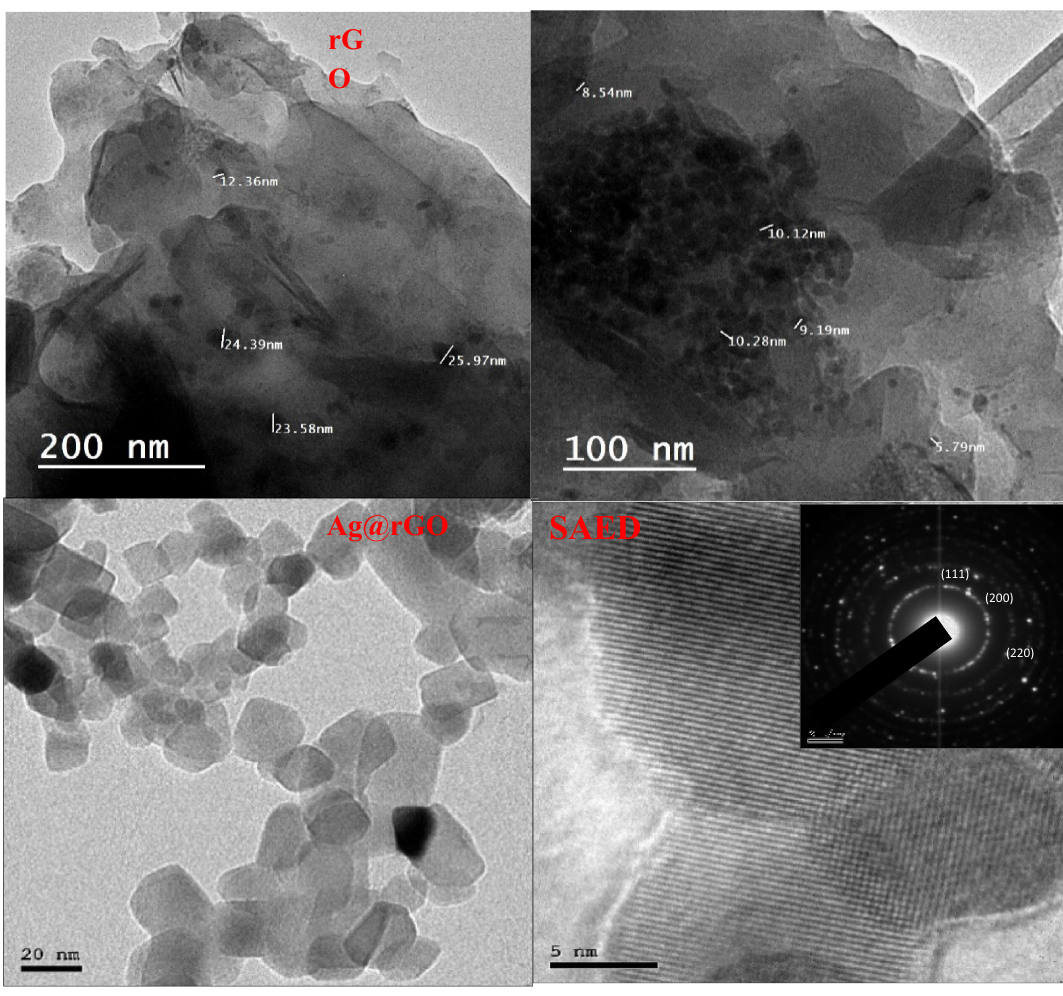
Fig. 6 Transmission electron microscope (TEM) and SAED images of as-synthesized rGO, rGO@Ag x% nanocomposites